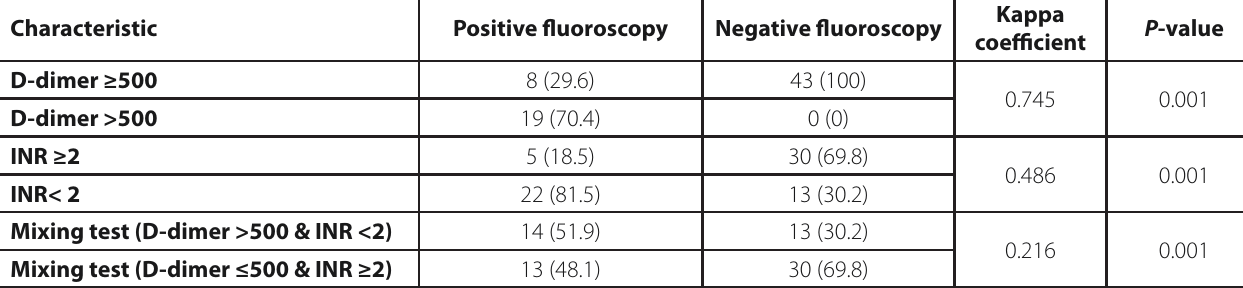
Table 2 . Relationship between fluoroscopy and biomarkers. Characteristic